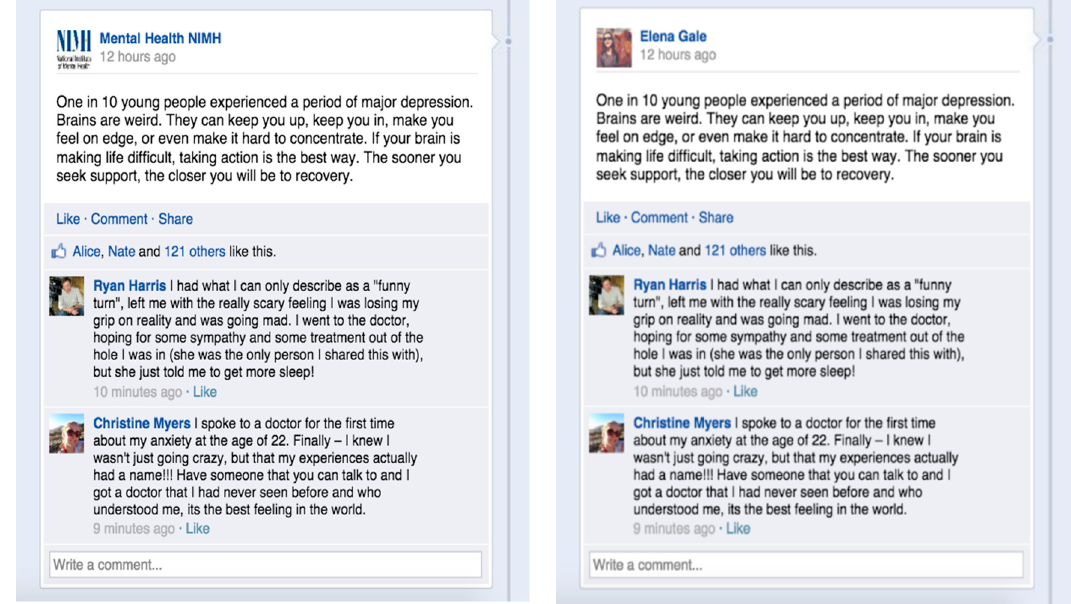
Figure 2. Professional Source 1 and Mixed Comments 1 a vs. Layperson Source 1 and Mixed Comments 1. a Each condition has three sets of screenshots. Professional source 1 and layperson source 1 have the same content except for account name and profile picture.